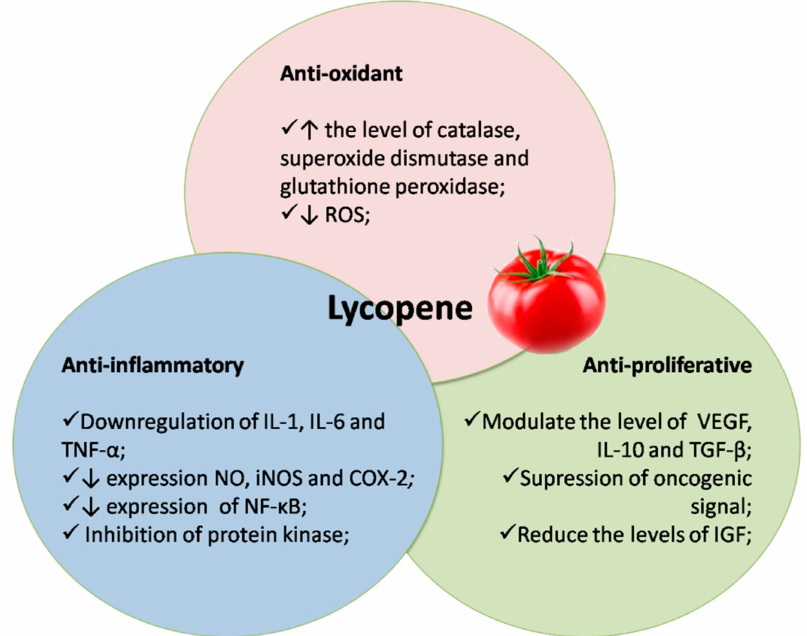
Figure 3. Schematic representation of the main mode of action of lycopene as anti-inflammatory and anti-cancer